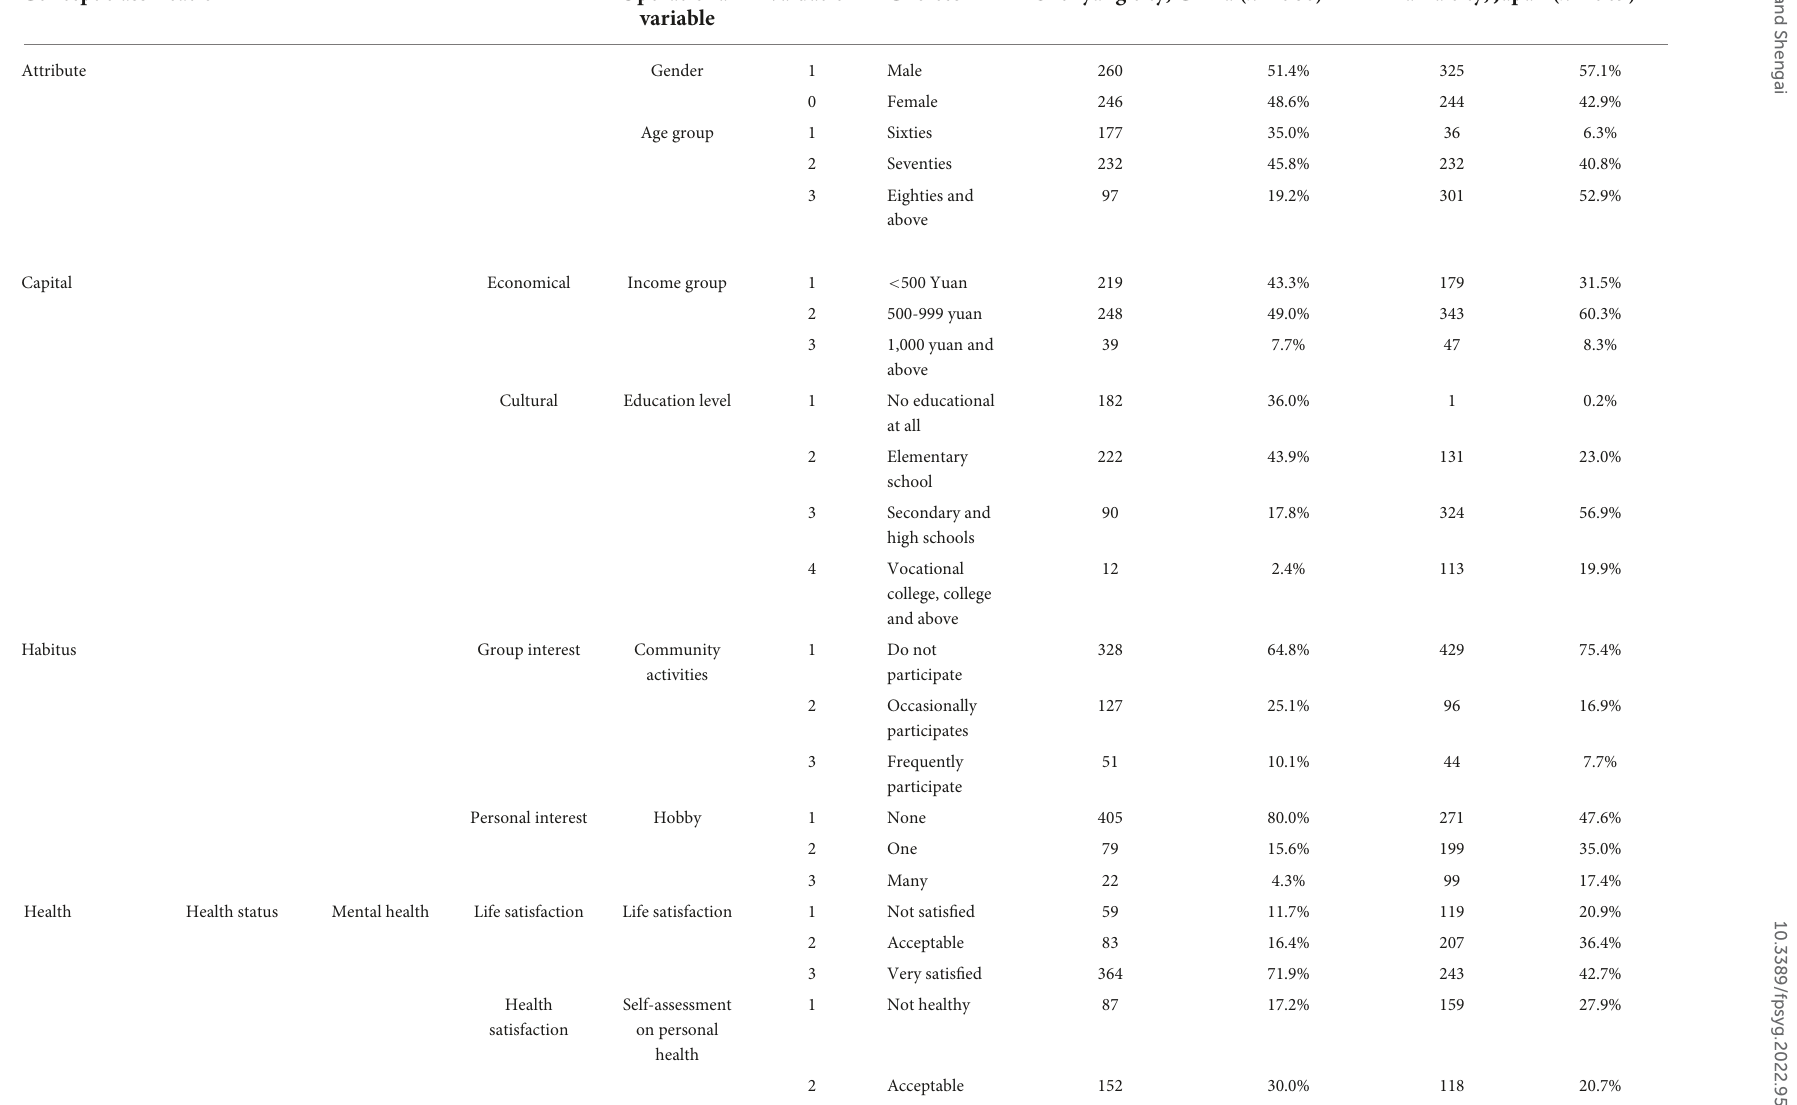
TABLE 1 Characteristics of the distributions of objects in Shenyang city and Tama city,